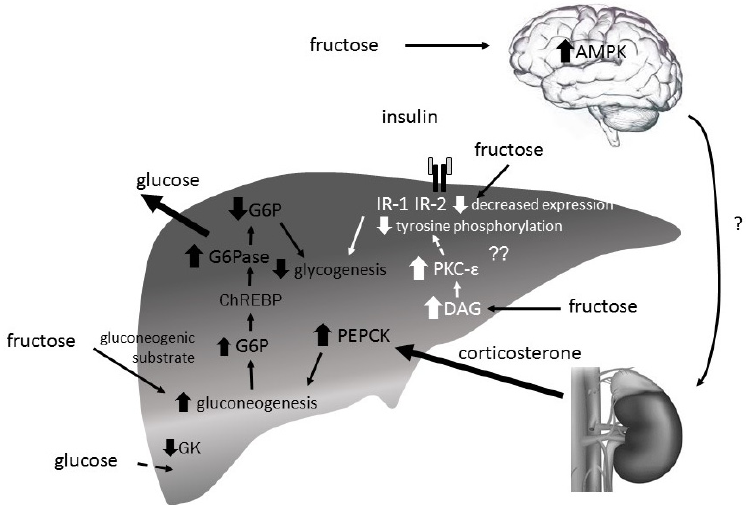
Figure 6. Proposed hypotheses explaining hepatic insulin resistance induced by fructose. (1) Increased diacylglycerols (DAG) levels activate (protein kinase C- ε ) PKC- ε leading via a cascade of serine-threonine kinases finally to a decreased tyrosine phosphorylation of insulin receptor 1 and 2 (IR-1,-2) which interferes with insulin signaling. Consequently, glycogen synthase activity decreases. (2) Fructose-induced hypothalamic activation of 5 (cid:48) -AMP-activated protein kinase (AMPK) increases via an unknown effector corticosterone release by the adrenal gland. The resulting enhanced phosphoenolpyruvate carboxykinase (PEPCK) expression increases gluconeogenesis. (3) Fructose-induced glucose-6-phosphatase (G6Pase) activity has been identified as main determinant of hepatic glucose production dominating over the suppressive effects of insulin. (4) Excessive fructose consumption may induce a significant posttranscriptional decrease in glucokinase (GK) protein